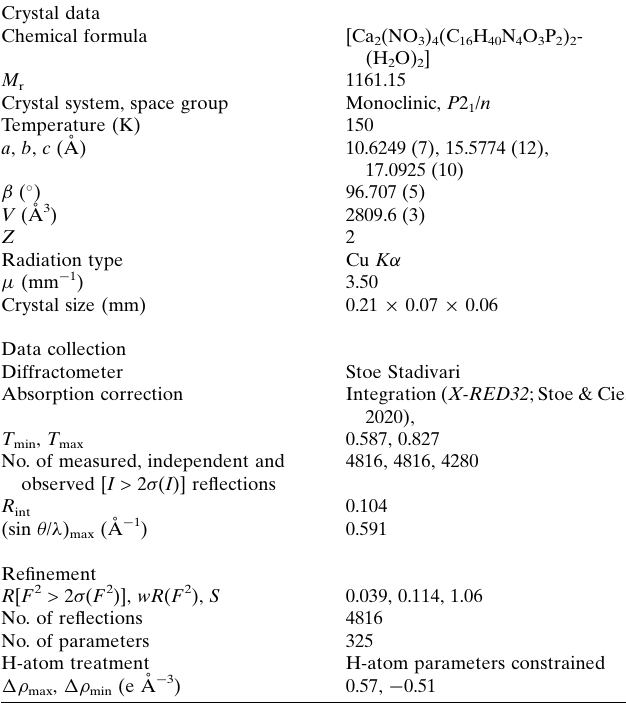
Table 3 Experimental details. Crystal data Chemical